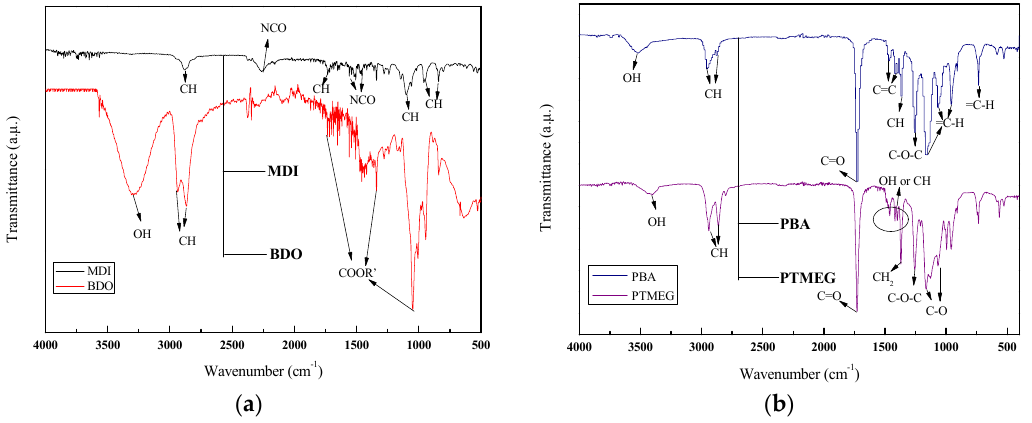
Figure 3. FTIR spectra of raw materials. ( a ) hard segment; ( b ) soft segment.